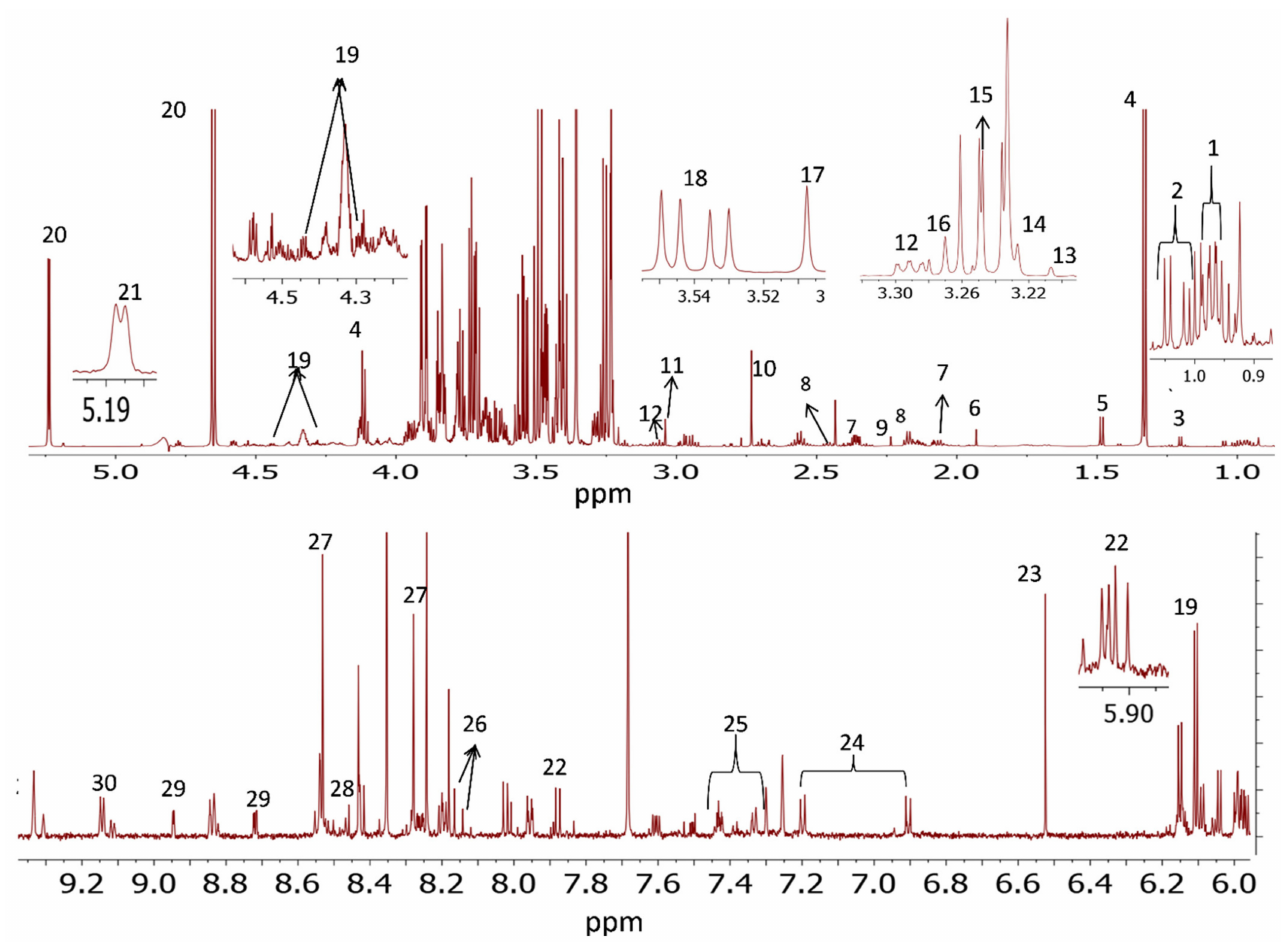
Figure 4. 700 MHz 1 H NMR spectrum of polar extract of Dorper sheep liver tissue: 1. leucine, 2. valine, 3. 3-Hydroxybutyric acid, 4. lactate, 5. alanine, 6. acetate, 7. glutamate, 8. glutamine, 9. acetone, 10. dimethylamine, 11. creatine, 12. anserine, 13. glycerophosphocholine, 14. choline, 15. carnitine, 16. betaine, 17. glycine, 18. glycerol, 19. inosine, 20. glucose, 21. a-Mannose, 22. uridine, 23. fumarate, 24. tyrosine, 25. phenylalanine, 26. hypoxanthine, 27. ADP/AMP/ATP, 28. formate, 29. niacinamide and 30.